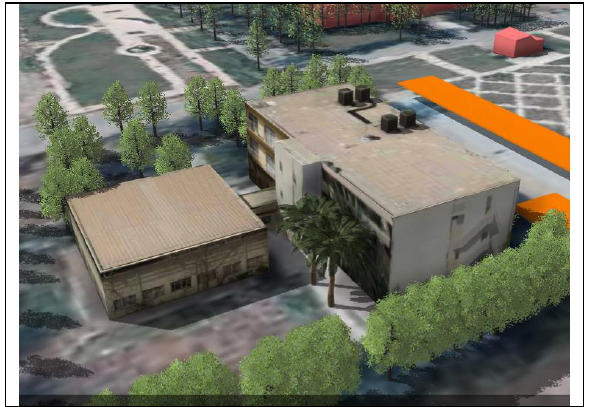
Figure 7. Assigning texture to the solid shape to obtain realistic impression